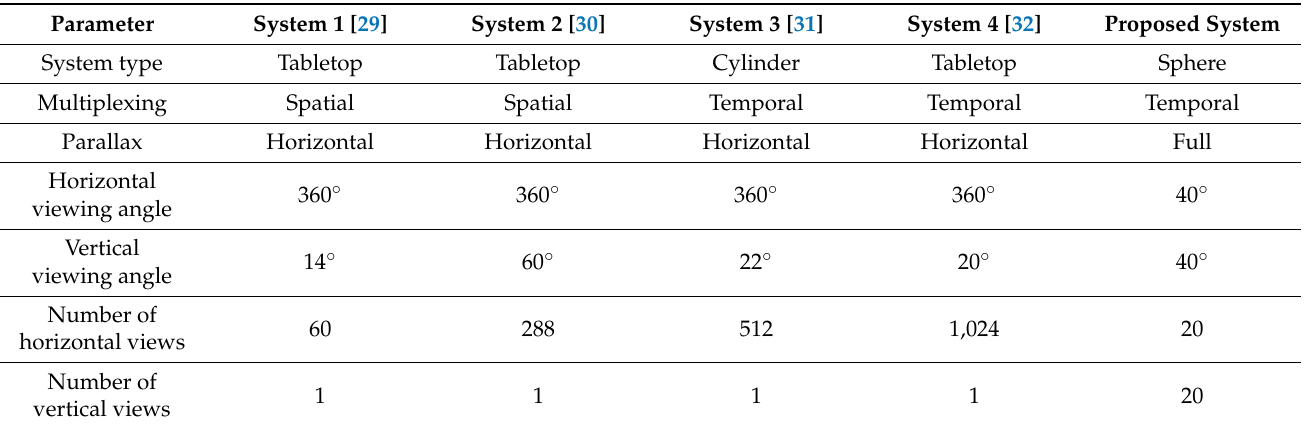
Table 3. Comparison of the proposed system specifications with other multiview displays using temporal multiplexing and spatial